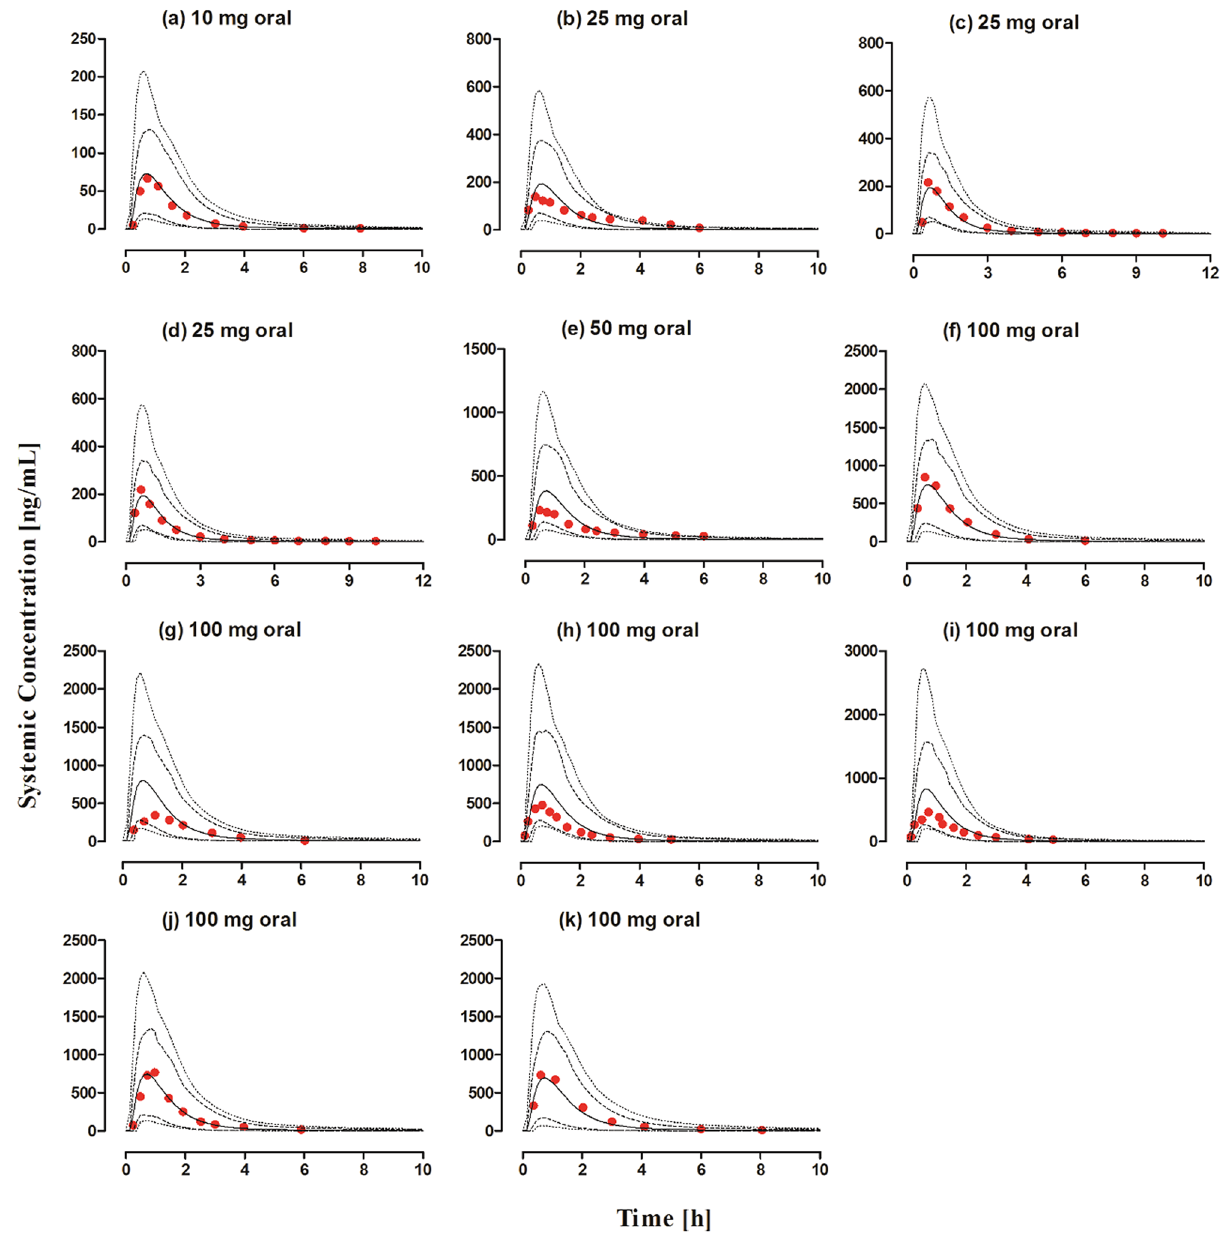
Figure 5. Observed and predicted systemic captopril concentration profiles in healthy individuals after oral administration. ( a ) 10 mg 18 , ( b ) 25 mg 42 , ( c , d ) 25 mg 41 , ( e ) 50 mg 42 , ( f ) 100 mg (fasting state), ( g ) 100 mg (fed state) 23 , ( h ) 100 mg (male), ( i ) 100 mg (female) 43 , ( j ) 100 mg 19 , ( k ) 100 mg (geriatrics) 44 . The observed data are shown as (red circles). The predicted results are shown as mean (solid line), maximum value, and minimum value (dashed line) and the 5th–95th percentiles (dotted